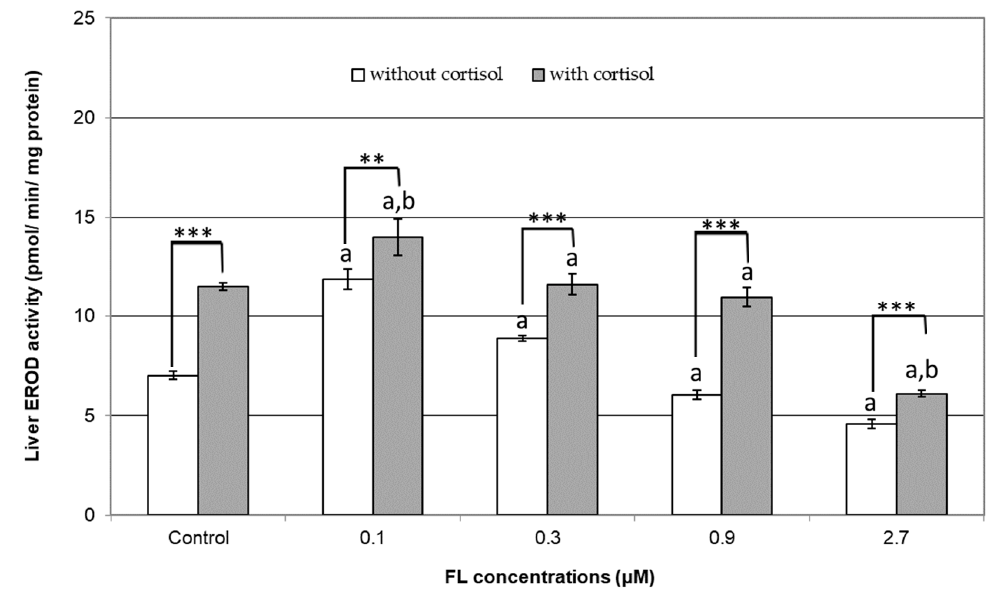
Figure 1. In vitro effects of fluoranthene (FL) on A. anguilla liver EROD activity in the presence and absence of cortisol (5.997 ng/mL). Bars represent mean ± SE ( n = 4). Asterisks (*), significant differences between the presence and absence of cortisol (** p < 0.01; *** p < 0.001); a, differences from control without cortisol; b, differences from control with cortisol. One-way ANOVA followed by Tukey’s post hoc test.